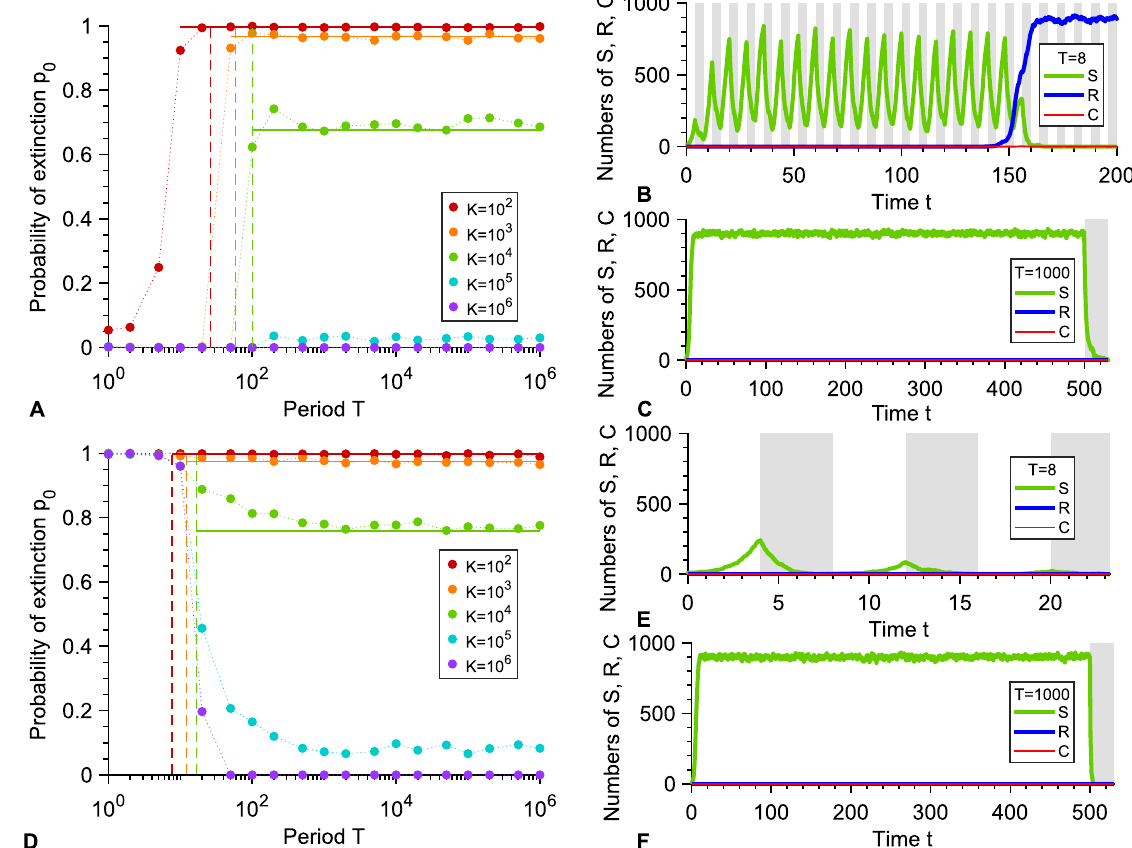
Fig 2. Periodic presence of a biocidal antimicrobial above the MIC. A: Probability p 0 that the microbial population goes extinct before resistance gets established versus alternation period T , for various carrying capacities K . Markers: simulation results, with probabilities estimated over 10 2 − 10 3 realizations. Horizontal solid lines: analytical predictions from Eq 4. Dashed lines: T /2 = τ S . B and C: Numbers of sensitive (S), resistant (R) and compensated (C) microorganisms versus time in example simulation runs for K = 1000, with T = 8 and T = 1000 respectively. In B , resistance takes over, while in C , extinction occurs shortly after antimicrobial is first added. Phases without (resp. with) antimicrobial are shaded in white (resp. gray). Parameter values in A , B and C : f S = 1, f R = 0.9, f C = 1, g S = 0.1 without antimicrobial, g 0 ¼ 1 : 1 with antimicrobial, g = g = 0.1, μ 1 = 10 − 5 and μ 2 = 10 − 3 . All simulations start with 10 S microorganisms. D , E and R C S F : same as A , B and C , but with g 0 ¼ 2 . All other parameters are the S